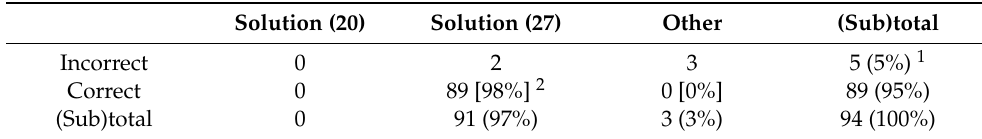
Table 5. Summary of solving the first-order linear ODE in the assignment in